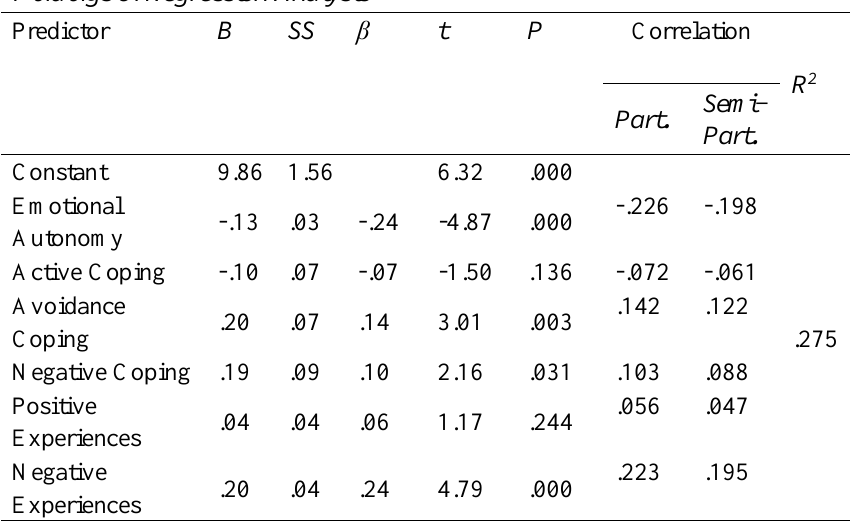
Findings of Regression Analysis